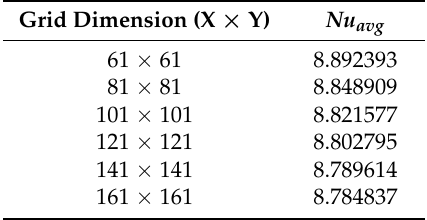
Table 3. Impact of grid size on Nu avg when Ra = 10 5 , Ha = 50, φ = 0.04, N = 4 and m = 16.1576.